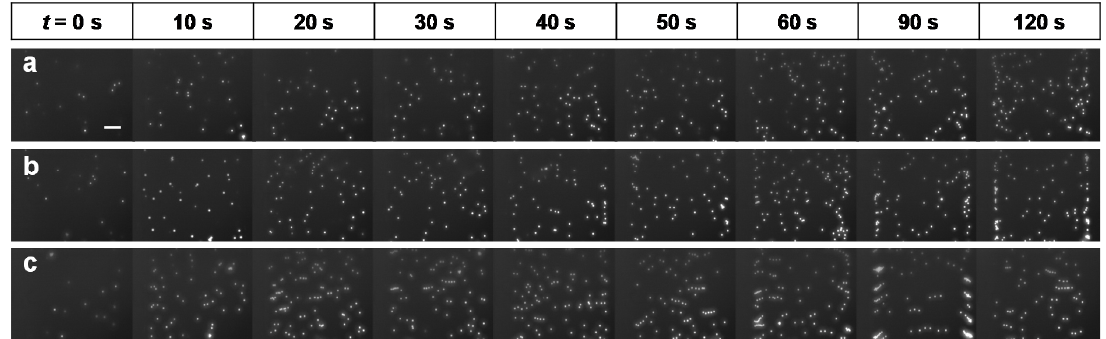
Figure 7. Particle confinement in the helical minichannel with 500 μ m depth for 10- μ m fluorescent beads suspended in 10% glycerol before (0 s) and after (10–120 s) spinning ( a ) at 1000 rpm, ( b ) at 2000 rpm and ( c ) at 3000 rpm. (scale bar = 0.1 mm).